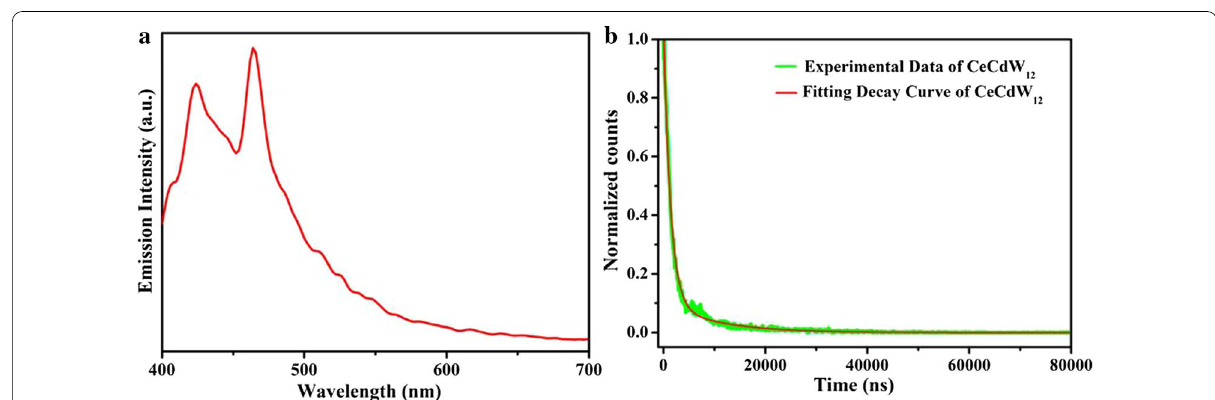
Fig. 14 a Emission spectrum of CeCdW 12 ; b PL decay curve of CeCdW